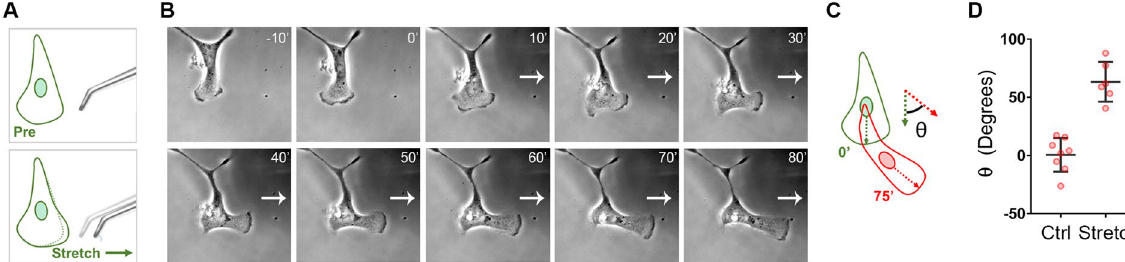
Figure 6. Ovarian cancer cells exhibit durotaxis. ( A ) SKOV3 cells plated on FN-coated hydrogels with rigidity of 25 kPa were allowed to adhere overnight before hydrogels were deformed with a glass micropipette and pulled orthogonal to a single migrating cell’s established direction of travel. Stretch was maintained over a period of 80 minutes with images taken every minute. ( B ) Example of a positive durotactic response. Time lapse imaging shows morphology and position of the SKOV3 cell at 10 minutes prior to stretch, immediately before stretch, and every ten minutes during stretch for 80 minutes. White arrow indicates direction of maintained stretch. ( C ) Durotactic response quantified as the turn angle ( θ ) determined as the angle of deflection from the original direction of travel after 75 minutes. Direction of travel at each time point established by a line drawn from the nucleus to the leading edge. ( D ) Quantification of turn angle of responding SKOV3 cells presented with durotactic stretch for 75 minutes compared to a similar number of control (Ctrl) cells not presented with a stimulus. Graph depicts all data points (red symbols) as well as the mean turn angle ( ± s.d.; n = 8 and 5 cells for control and stretched cells, respectively; p = 0.007 by the Mann-Whitney test).